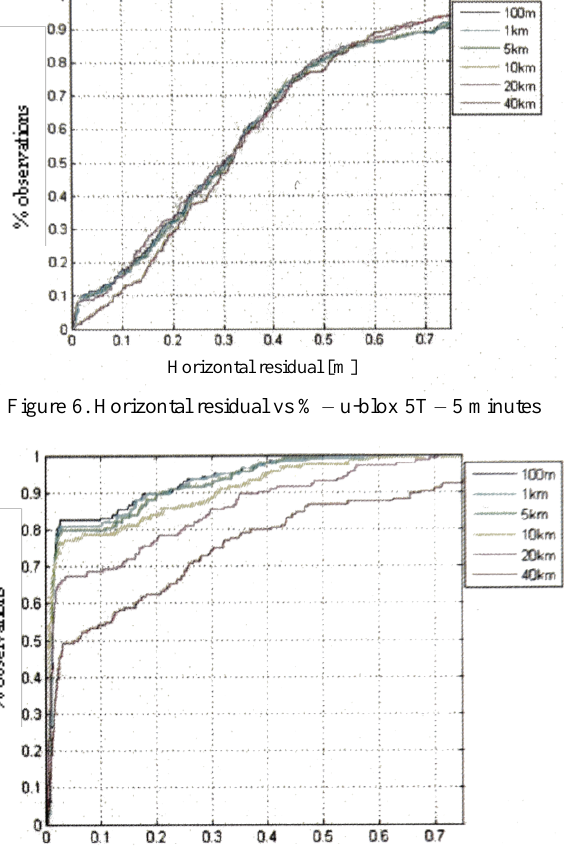
Figure 4. VRINEX with different ellipsoid heights with respect to the CORS (Torino)